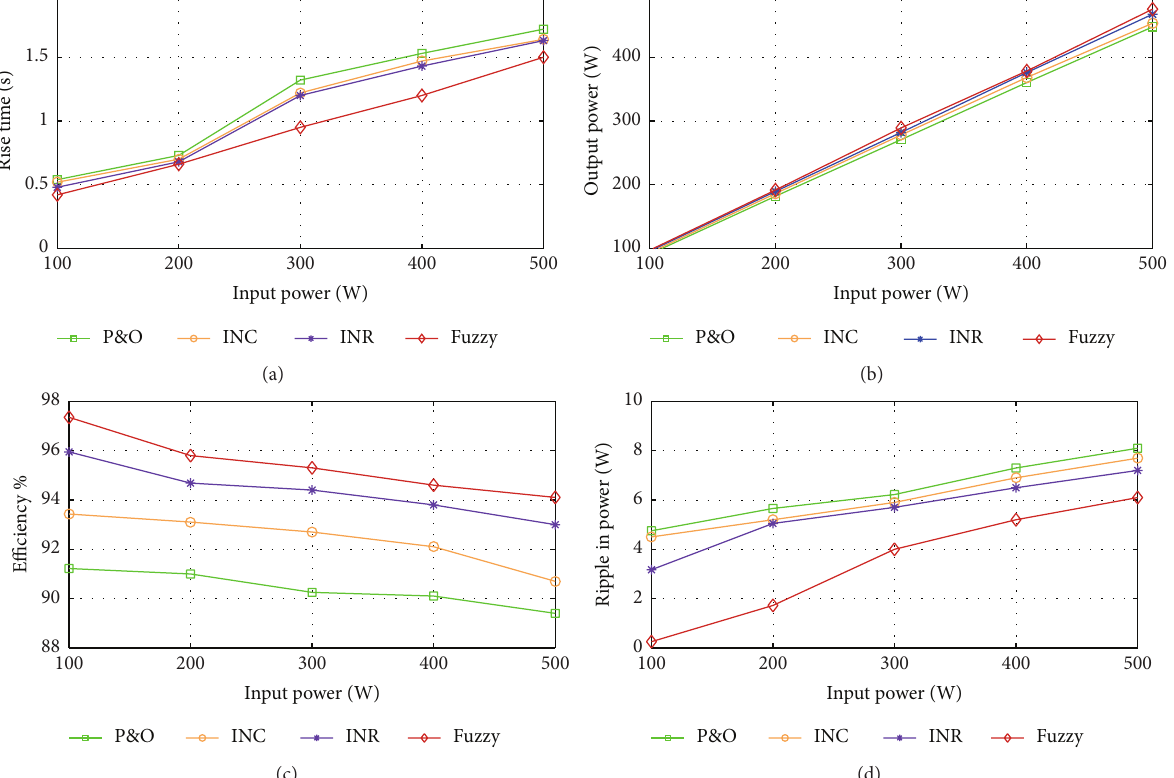
Figure 13: Comparison of performance parameters of different algorithms with respect to (a) rise time, (b) output power, (c) efficiency, and (d) output